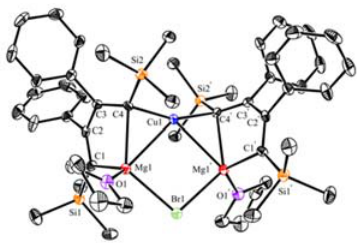
Scheme 6. Rigid magnesium organocuprates [58].